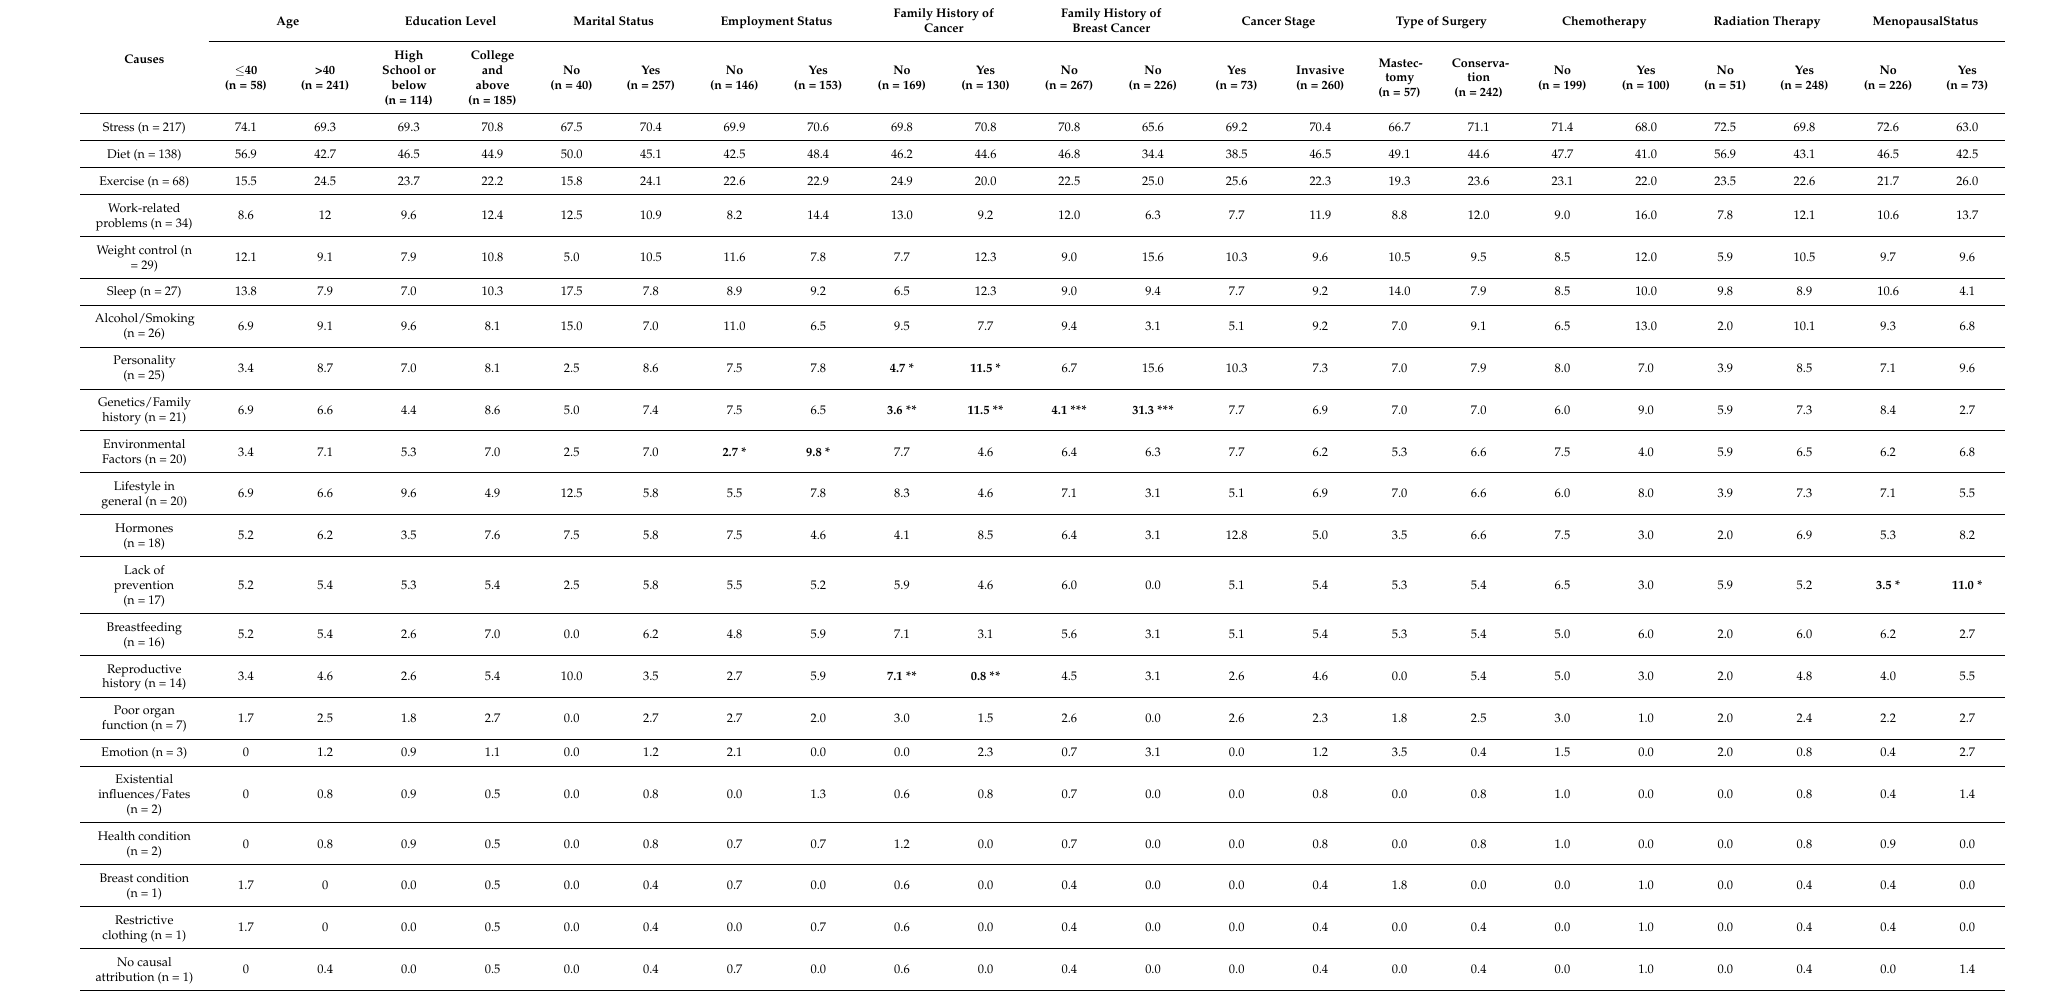
Table 3. Causal attributions according to patient demographic and clinical characteristics ( n =